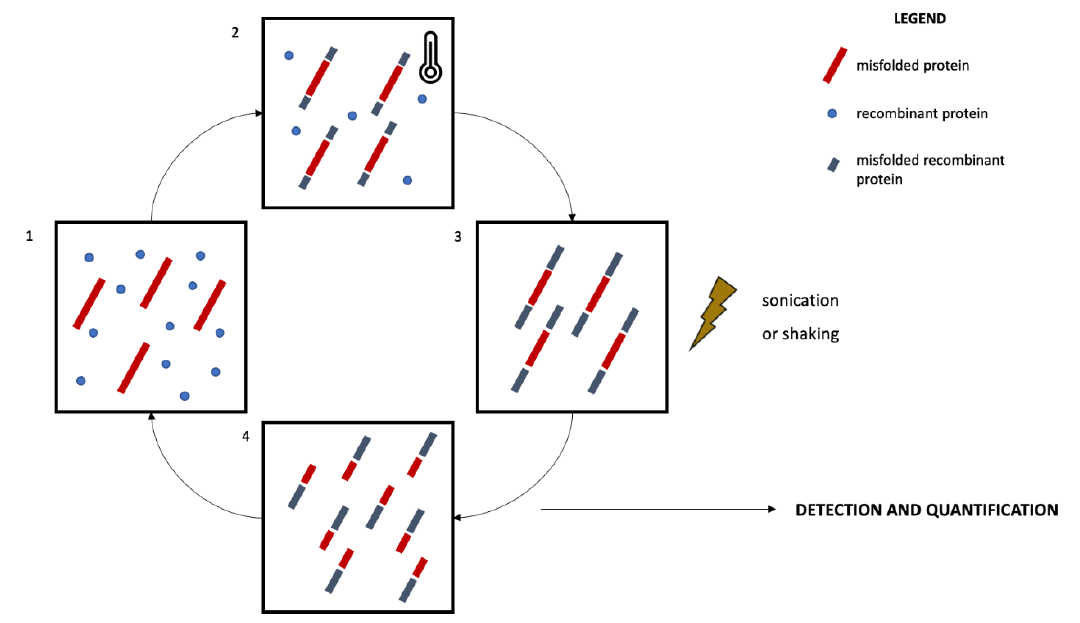
Figure 1. Schematic representation of the protein misfolding amplification assays. The recombinant protein is incubated with the biological sample containing an amount of the misfolded protein to be quantified for a defined time and at a specific temperature (1, 2). This process promotes the further misfolding of recombinant proteins and the elongation of the fibrils (nucleation, 3). The sample then undergoes a sonication (PMCA) or shaking (RT-QuIC) process promoting the fragmentation of the fibrils (4) and the amplification of seeds promoting further misfolding and amplification. The incubation-sonication/shaking cycles (2, 3, 4) are repeated several times, enabling the amplification of small amounts of misfolded proteins. The quantification process occurs real-time in RT-QuIC by means of a fluorescent dye, while it occurs at the end of the incubation-sonication cycles in PMCA by means of Western blotting